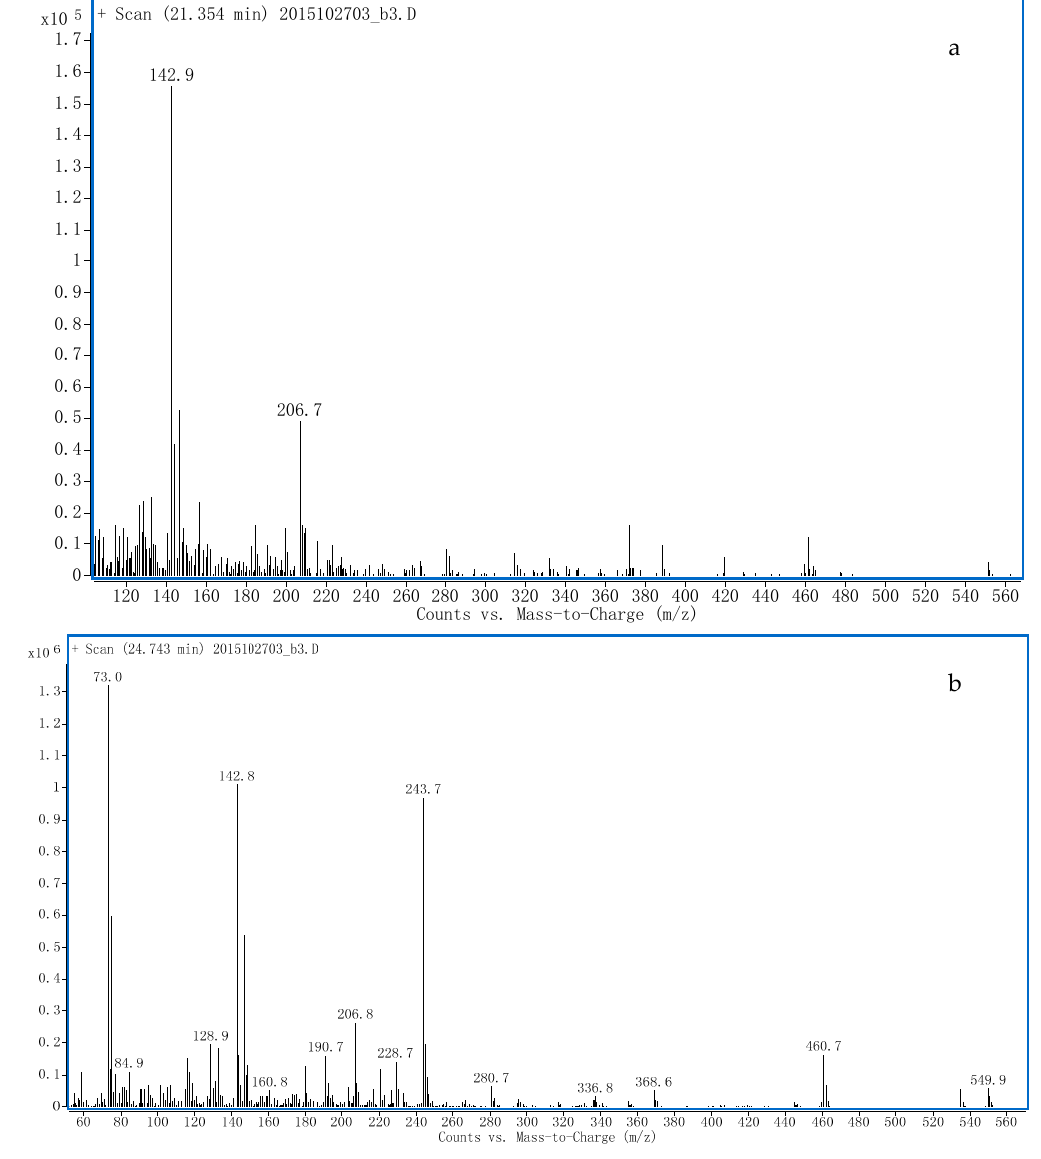
Figure 5. The Electron ionization mass spectra of TMS derivatives of the phase II metabolites of: S1 ( a ); and S2 ( b ) released after hydrolysis.